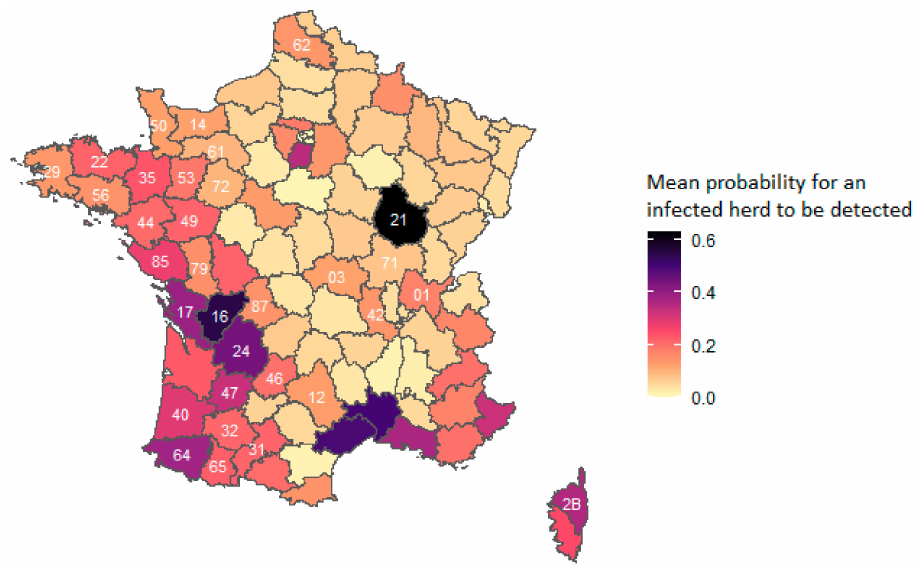
Figure A2. Mean probability for an infected herd to be detected via ante-mortem surveillance for a prevalence set at 0.1%.